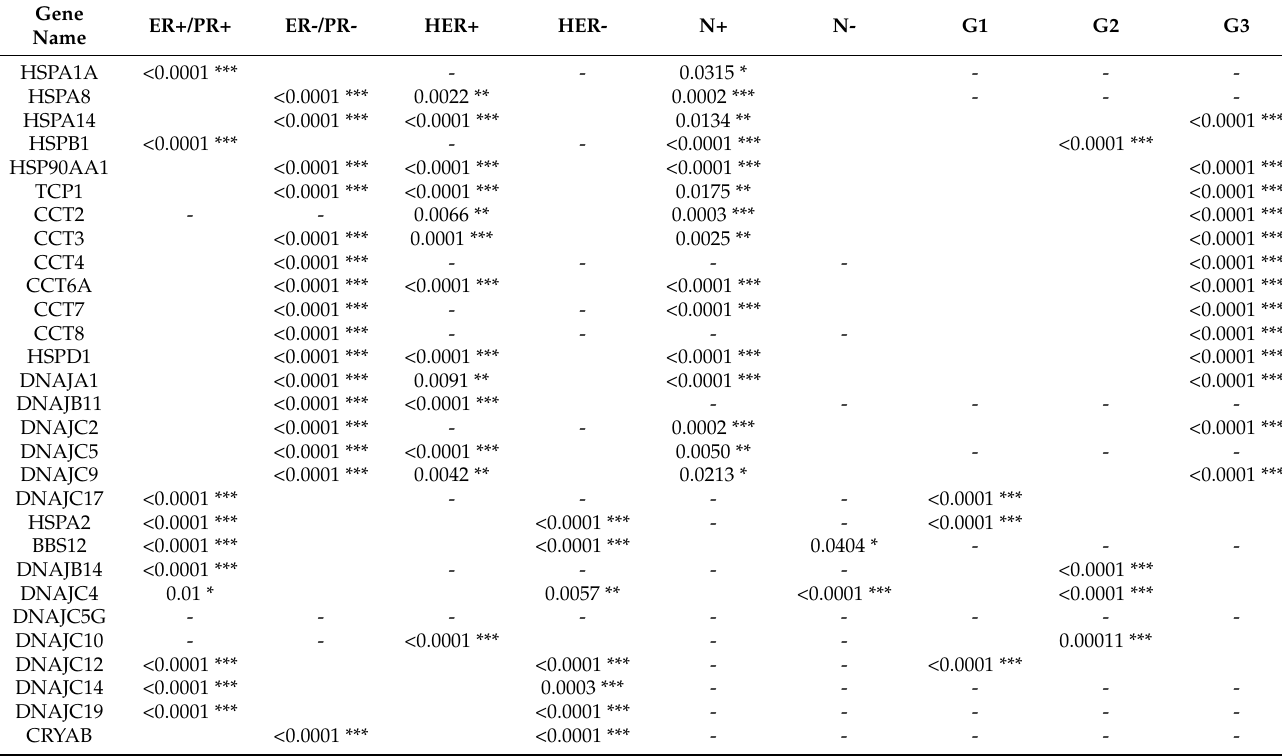
Table 4. Relationship between HSPs mRNA expression in BC and clinical-pathological parameters, including estrogen receptor (ER), progesterone receptor (PR), and human epidermal growth receptor 2 (HER) status, lymph node (N) involve- ment, and grading (G1–G2–G3). Data were retrieved for each HSP using bcGeneXMiner and the grading was assessed using GOBO database. p < 0.05 was considered significant ( p < 0.05 *, p < 0.01 **, p < 0.001